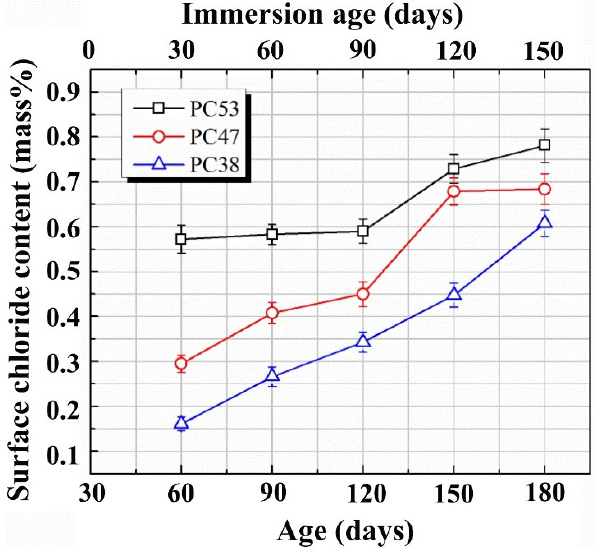
Figure 2. Evolutions of the surface chloride concentrations of plain cement concretes as immersed in NaCl